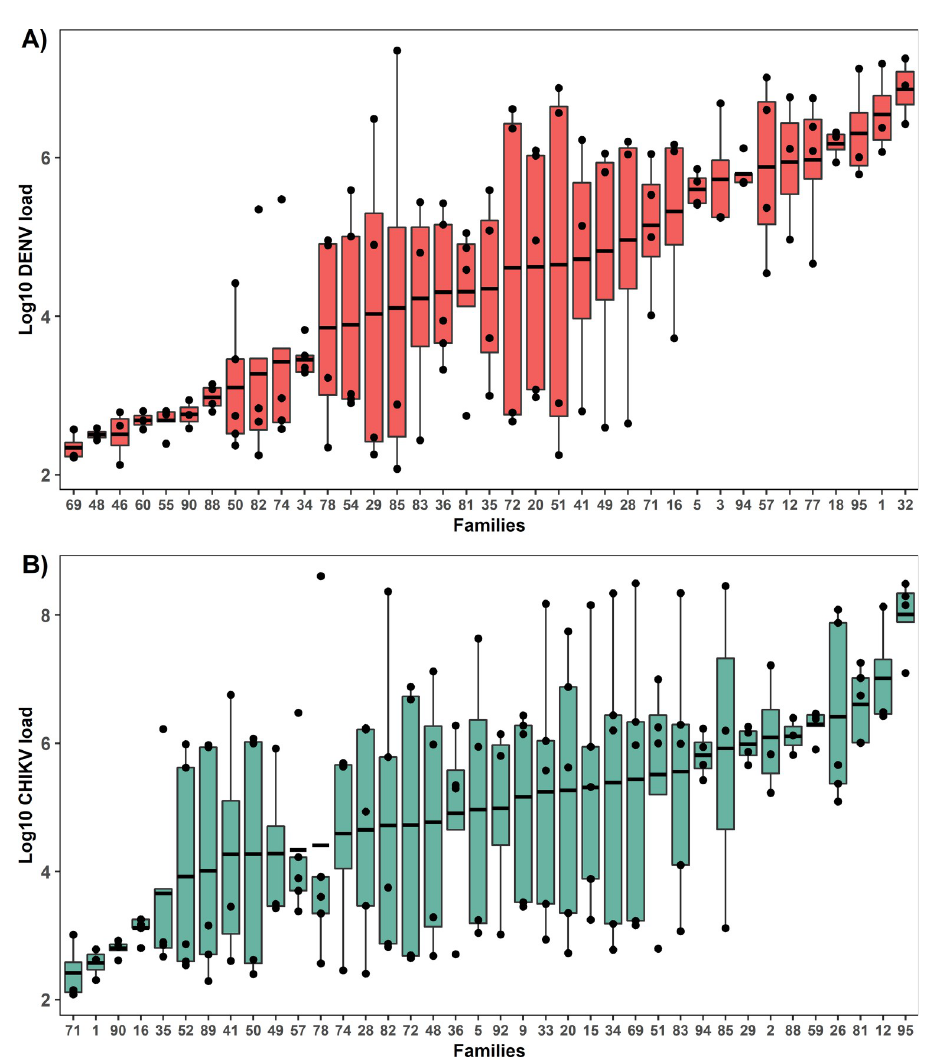
Fig 2. Ranked families by viral load. We ultimately obtained data from 37 families from > 600 initial paired crosses. A) DENV load-ranked families and B) CHIKV load-ranked families. Each point represents a single infected mosquito. Box plots show mean viral load ± SEM of each distinct Ae . aegypti family. Whole mosquito viral load was log10 transformed. N = 3–5 individuals per